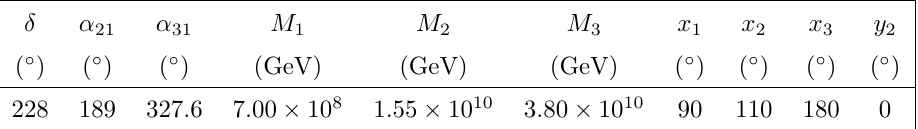
Table 4 . A benchmark point for intermediate scale leptogenesis with quasi-degenerate (QD) spec- trum of the light neutrino masses. In addition to the parameters listed we have m 1 = 0 : 215 eV and 140 (cid:14) and corresponding (cid:12)ne-tuning y 1 = y 3 = (cid:0)